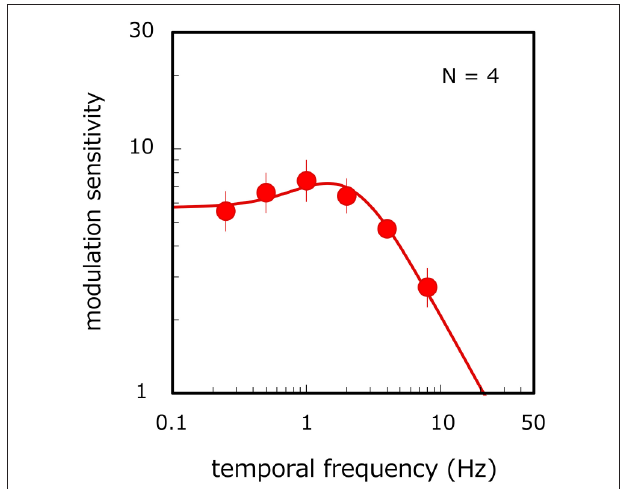
FIGURE 3 | Temporal-frequency modulation sensitivity for luminance flicker. Filled circles and MTF curve show results averaged across observers. Error bars represent ± 1 SE across